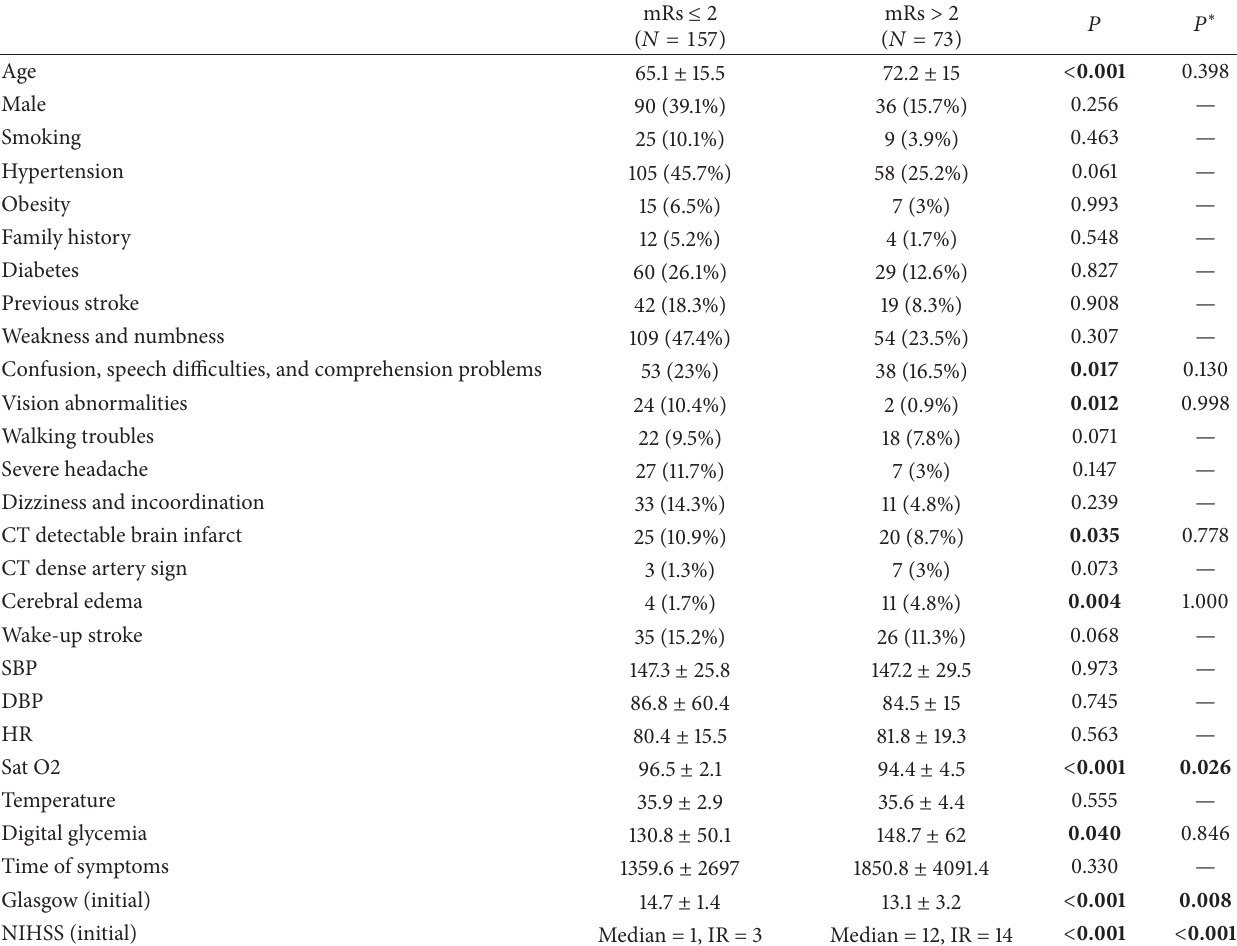
Table 2: Comparison of clinical and radiological data according to the modified Rankin score (mRs) at